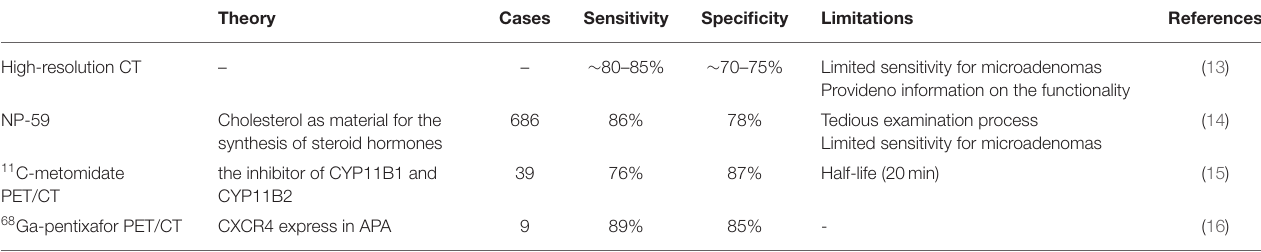
TABLE 2 | Comparison of various adrenal images in the diagnosis of primary